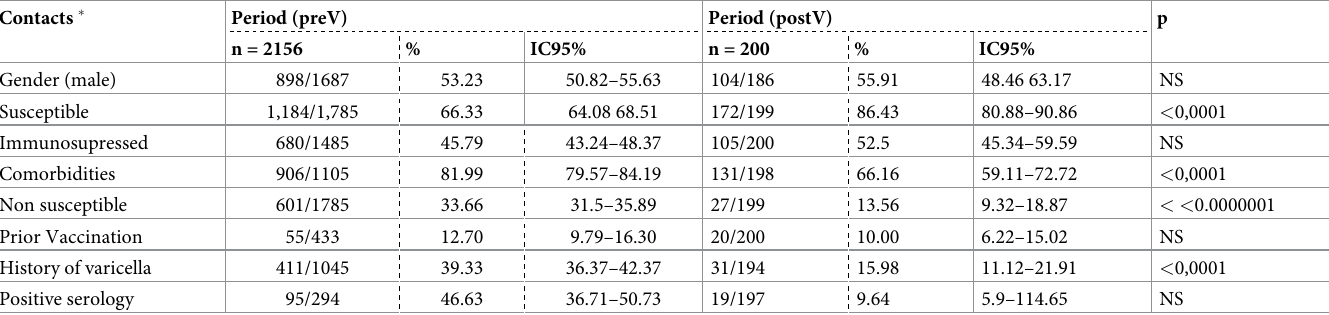
Table 2. Epidemiological and clinical characteristics of contacts in pre- and post-vaccination periods. Contacts �